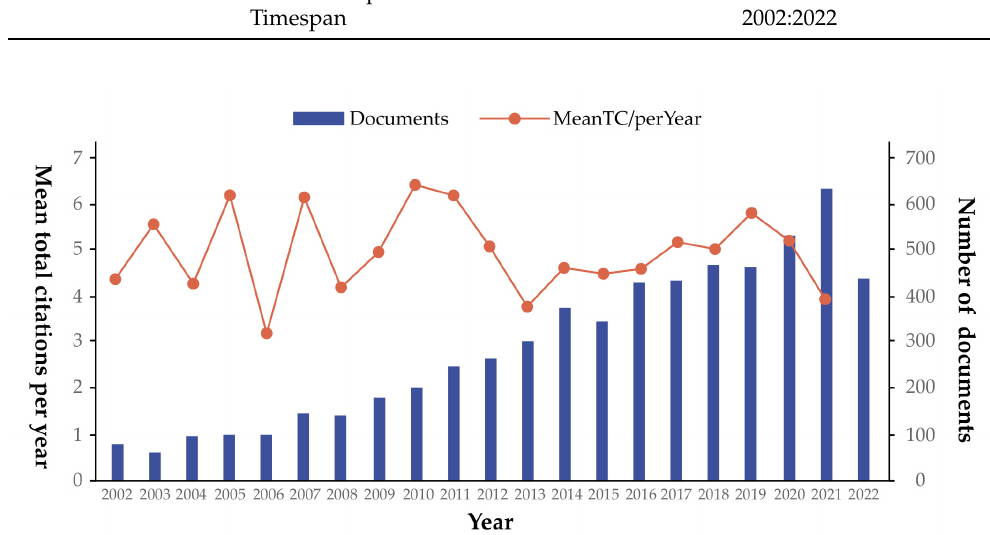
Figure 2. Annual production and average annual citation rate of research related to forest manage- ment in a carbon-neutral context from 2002 to